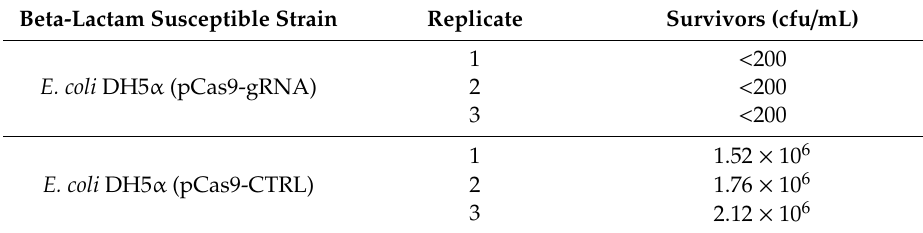
Table 1. The evolutionary rescue of CRISPR-plasmid harboring antibiotic susceptible E. coli